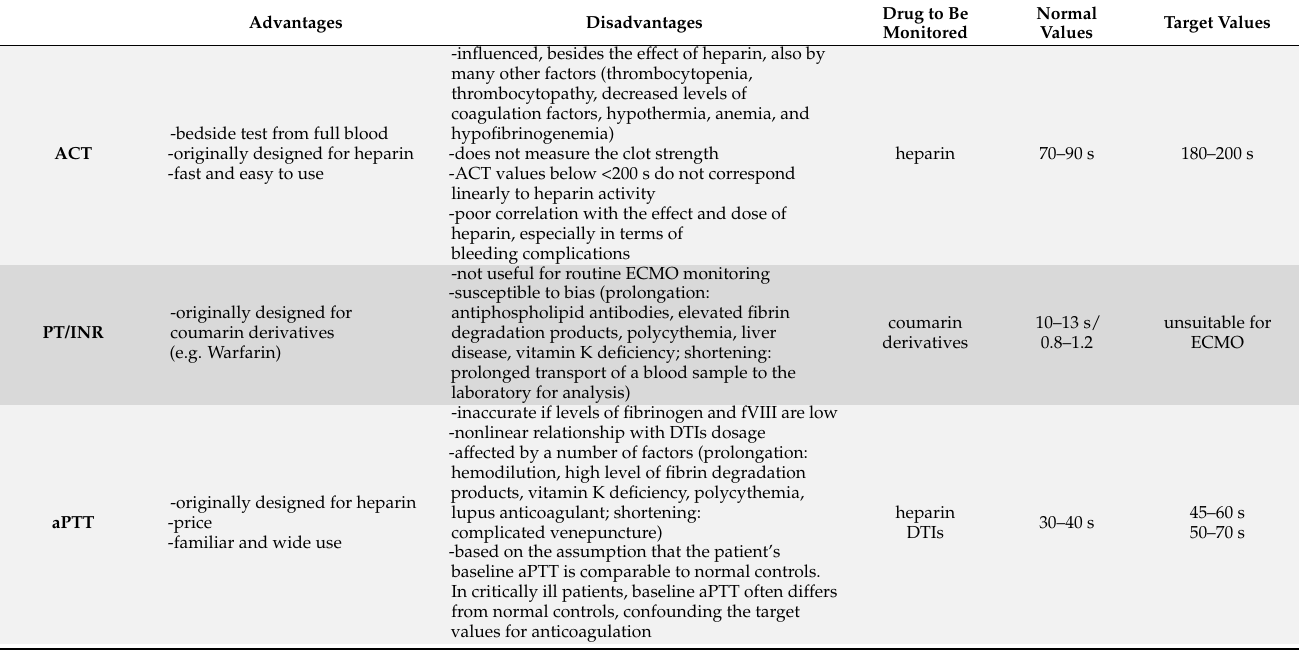
Table 2. Main properties of anticoagulation tests for ECMO. PT-prothrombin time; INR-international normalised ratio; ACT-activated clotting time; TT-thrombin time; FDP-Fibrin degradation